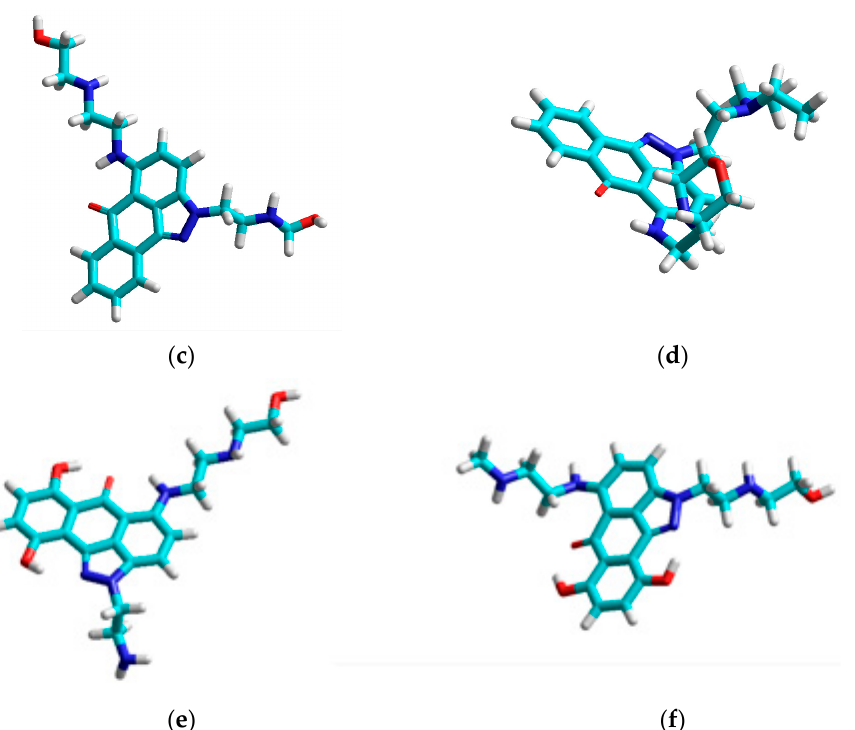
Figure 1. Geometrically optimized structures of selected anthrapyrazole derivatives: ( a ) a-01; ( b ) a-08; ( c ) a-18; ( d ) a-30; ( e ) a-50; ( f ) a-60.